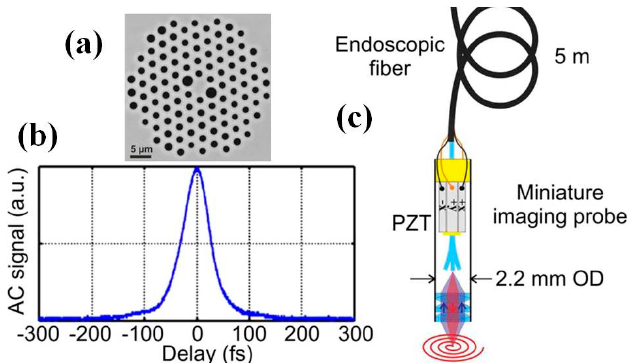
Figure 17. Scanning fiber based two photon endomicroscope system. ( a ) Close view of the inner core of the custom-design air-silica DC-PCF through scanning electron microscopy (SEM). Pure silica is in grey and air in black. ( b ) Second order autocorrelation (AC) of the IR excitation pulse at the exit of the 5-m-long endoscopic fiber for a delivered power of 20 mW. The pulse duration has been calculated from the AC duration by using the suitable conversion factor (i.e., 1.54 = (AC duration)/(pulse duration) at FWHM. Accordingly, the pulse duration was equal to 39 fs (FWHM). ( c ) Scheme of the miniature fiber scanning imaging probe which is embedded inside a 2.2 mm outer diameter (OD) stainless steel biocompatible tube (R eproduced with permission from Nature Publisher Group [107]).